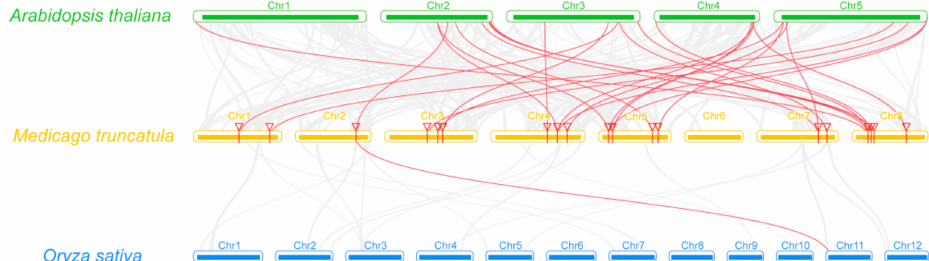
Figure 3. Synteny analysis of MtP450 genes between M. truncatula and two representative plant species ( A. thaliana and O. sativa ). Gray lines in the background indicate the collinear blocks within M. truncatula , and A. thaliana / O. sativa , while the red lines highlight the syntenic MtP450 gene